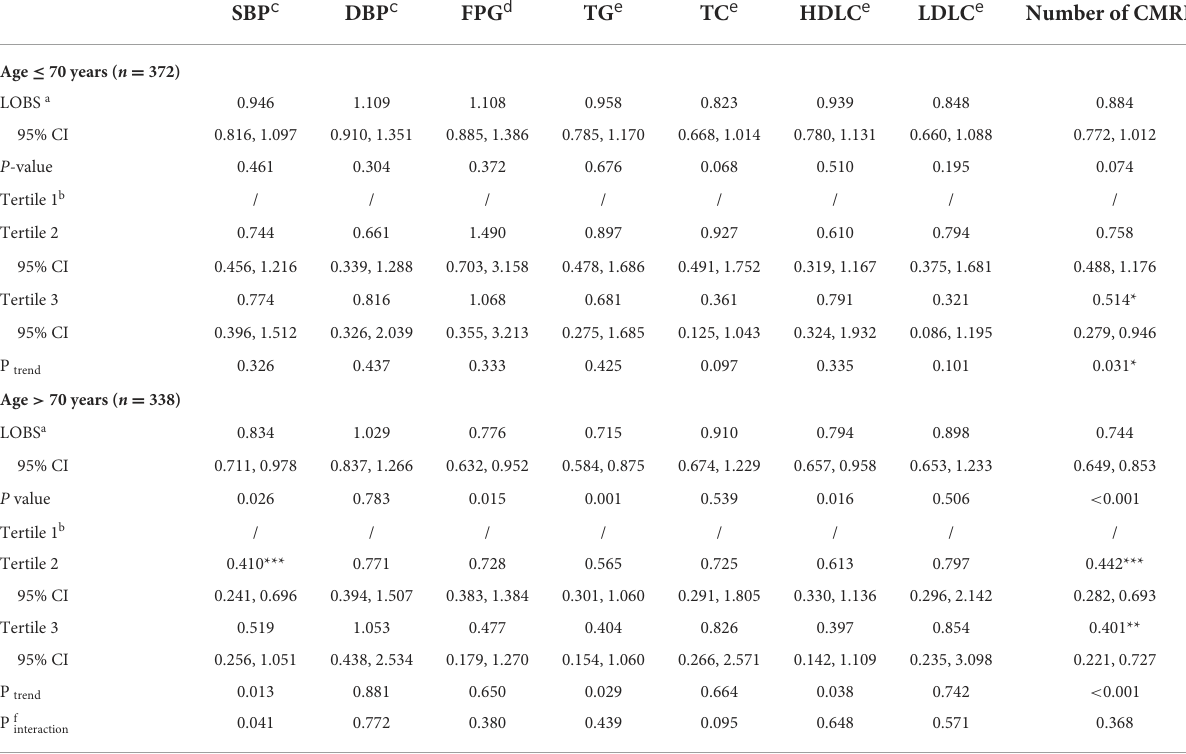
TABLE 4-2 Associations of the lifestyle-based oxidative balance score with the number of cardiometabolic risk factors and cardiometabolic biomarkers by age using logistic